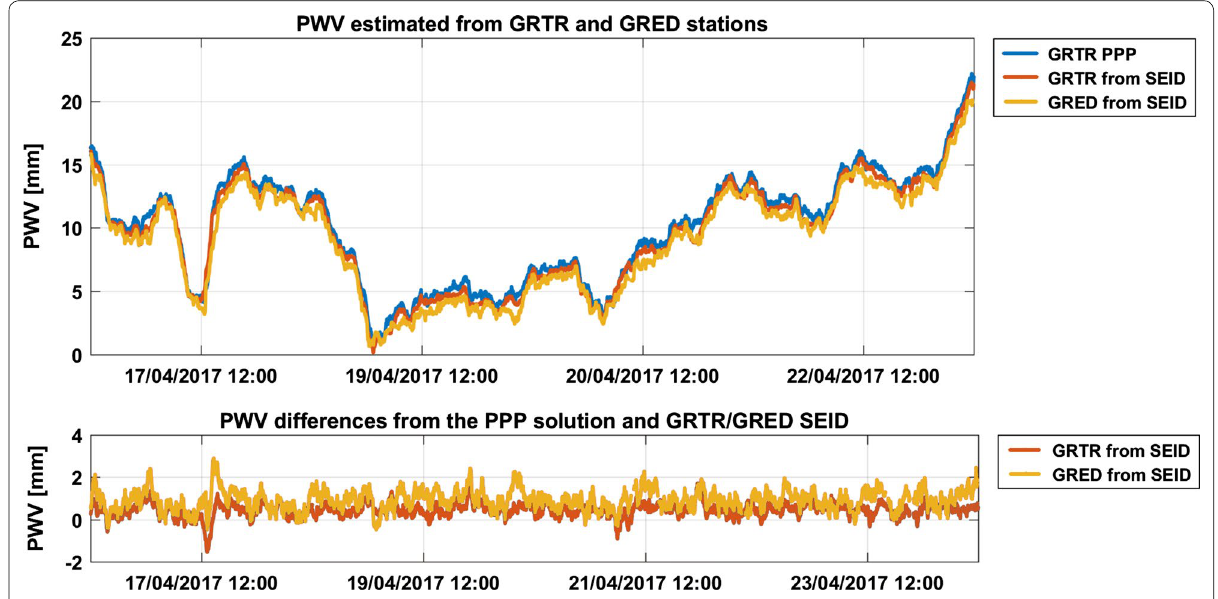
Fig. 13 Comparison between PWV time series derived from a geodetic (L1-only) station and from a low-cost station for a 1-week